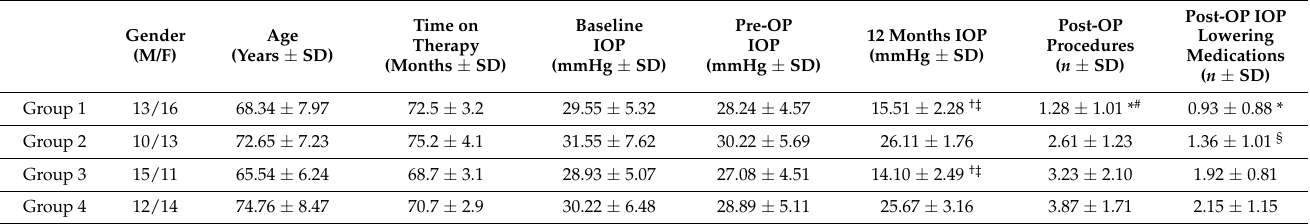
Table 1. Demographic and clinical data.